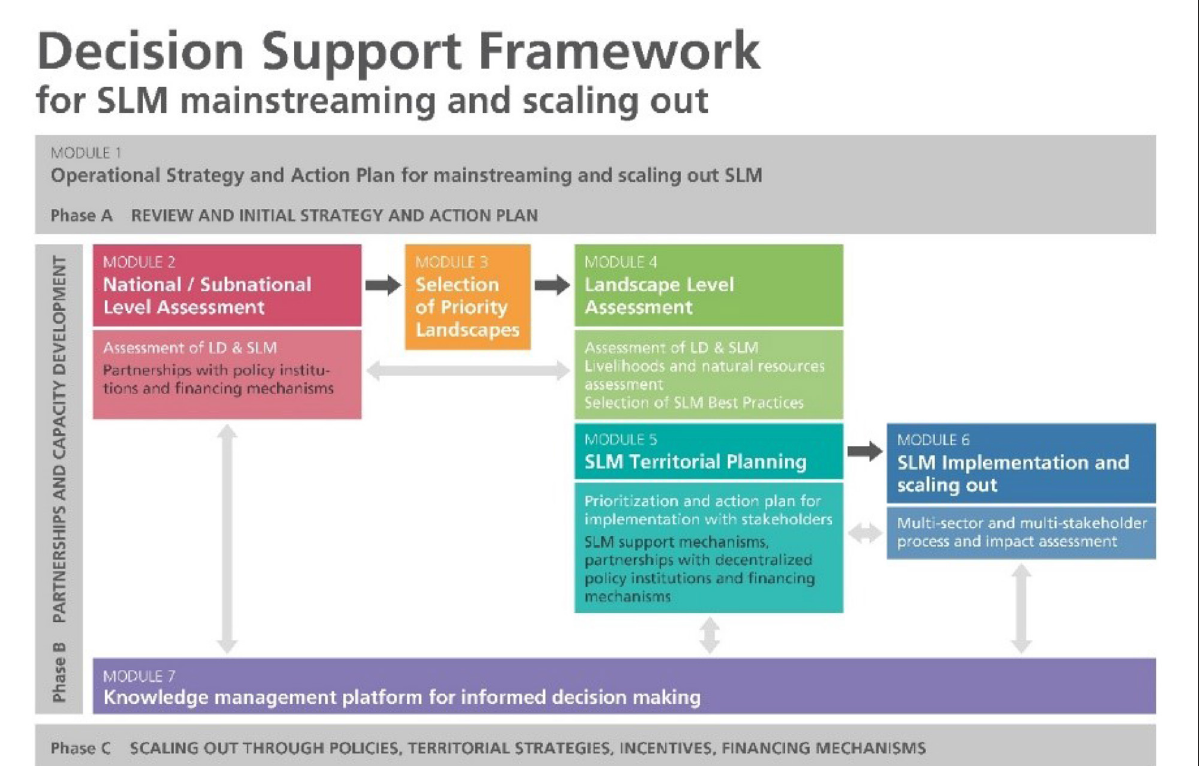
FIGURE1 The modular structure of the Decision Support Framework (DSF) (source: Liniger et al., 2019; Harari et al., 2022 to be published).